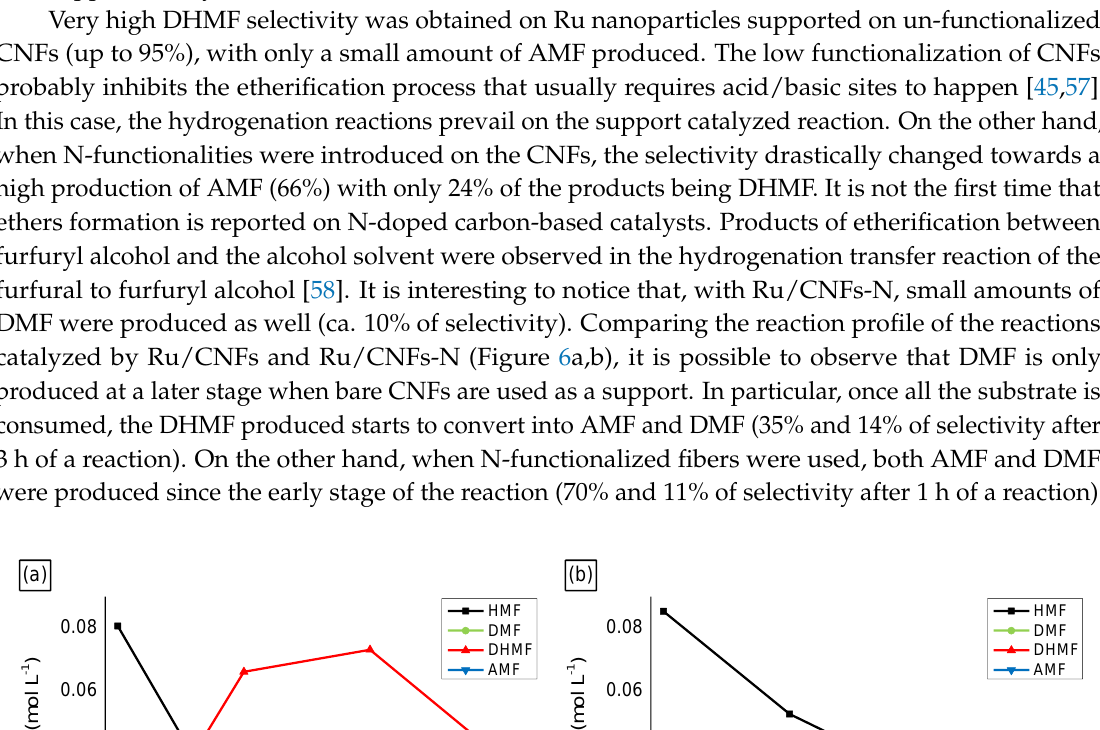
Figure 7. HMF hydrogenation reaction profile on Ru/CNFs-O. Reaction conditions: HMF, 0.08 M, substrate/metal = 100 mol/mol, solvent, 15 mL 2-butanol, 150 °C, 20 bar H 2 . Lastly, the Ru/CNFs-P catalyst showed not only a low catalytic activity (Figure 5) but also poor product selectivity (Figure 8), with both DHMF and AMF being produced in a similar amount (47% and 44% of selectivity after 3 h of the reaction).